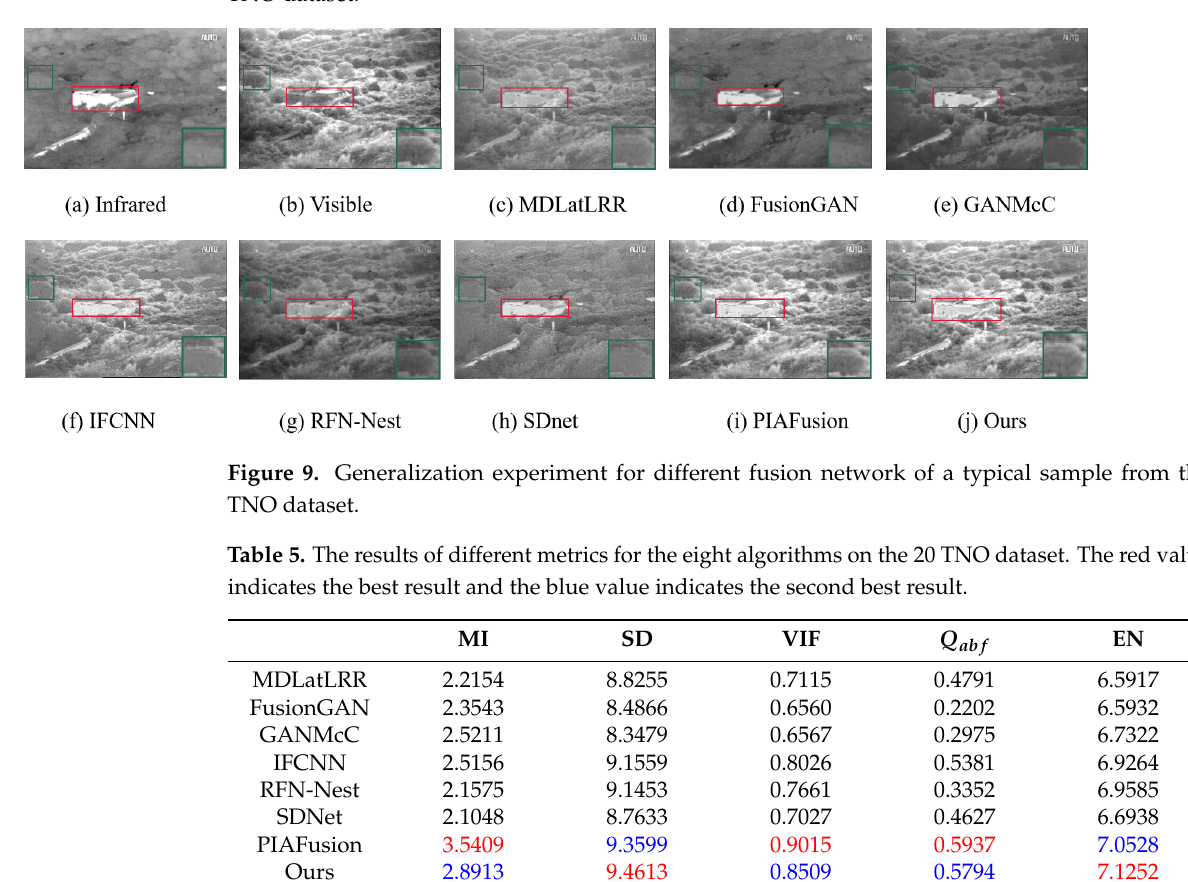
Figure 8. Generalization experiment for different fusion network of a typical sample from the TNO dataset.